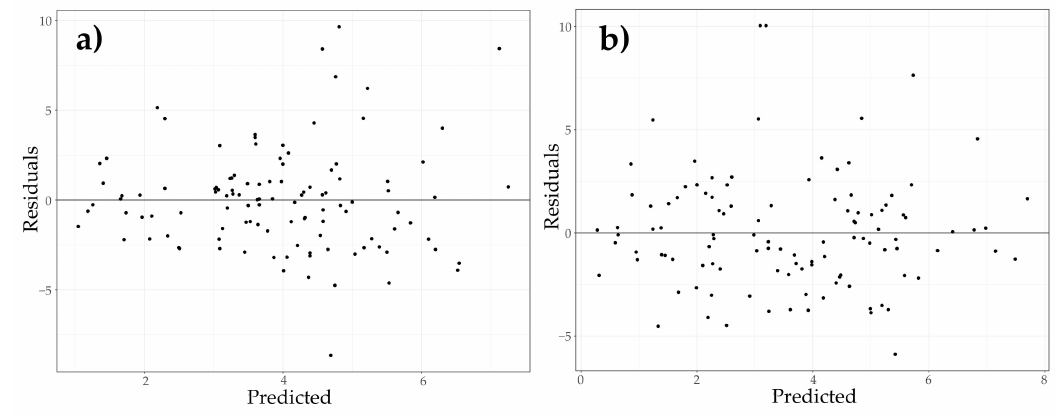
Figure 8. Graph of residues against predicted model values. ( a ) Diameter at breast height and total height estimated with UAV; ( b ) basal diameter and crown diameter estimated with